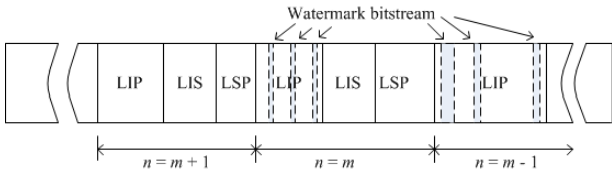
Fig. 6 Bit-stream structure in the partial message embedded in the entry coding of